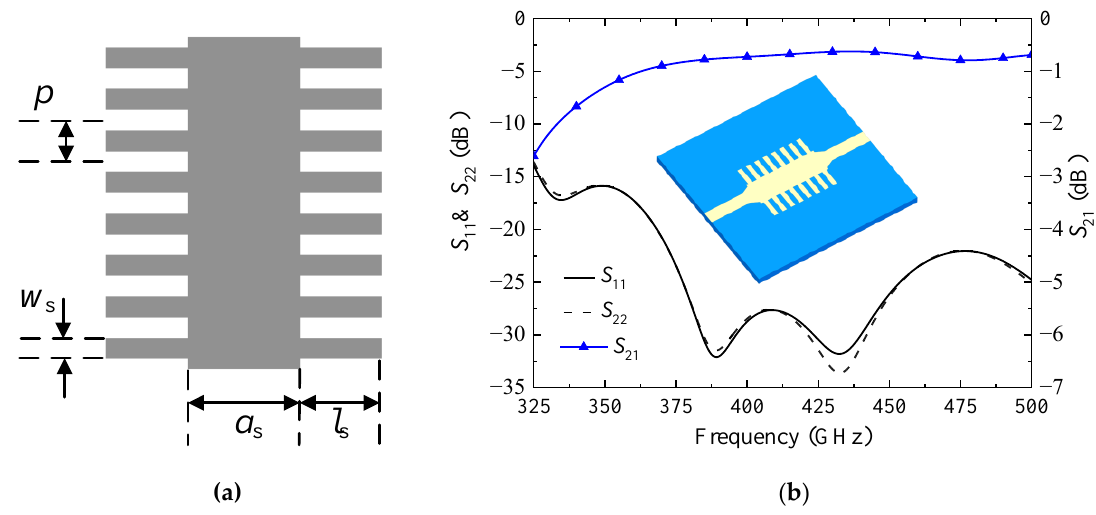
Figure 4. ( a ) Layout of the CSIW; ( b ) Simulated results of the CSIW fed by MSL.